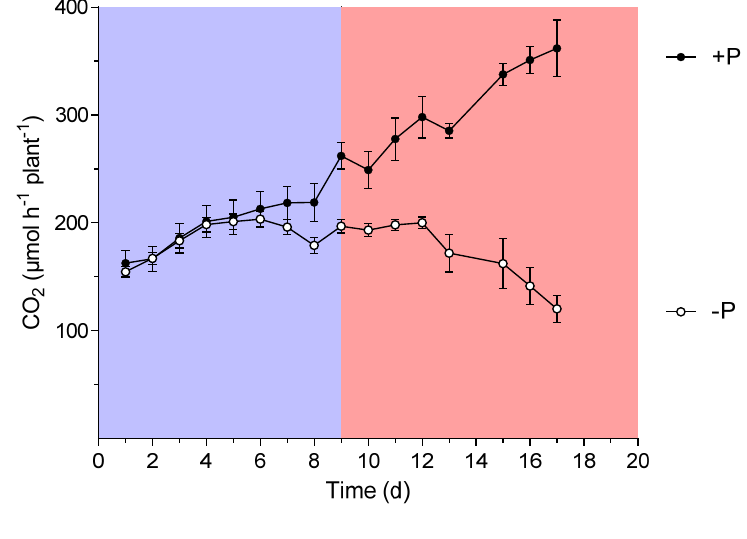
release of M . truncatula wild-type plants grown at sufficient P Figure 3. Root/nodule CO 2 supply (+P) and during P depletion ( − P). Data are given as means of six replicates ± SE. Each point represent the amount of CO evolved measured at 11 am. The dotted line 2 indicates the point in time when treatments began to differ significantly ( t -test, p < 0.05). The colors distinguish the period of significantly different ANA (reddish) from the period evolution of P depletion but not yet different CO 2